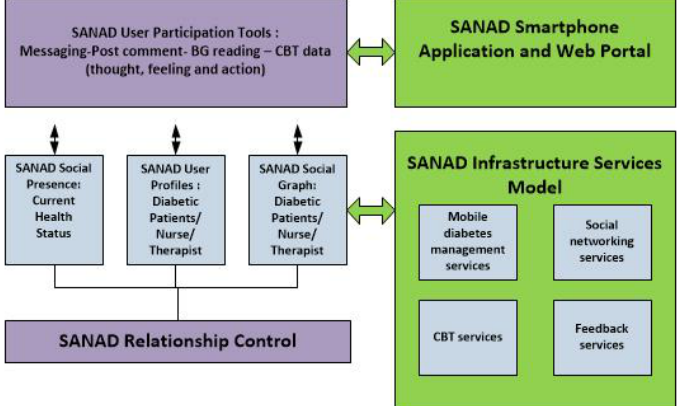
Figure 3. Building blocks of the Saudi Arabia Networking for Aiding Diabetes (SANAD) system. BG: blood glucose; CBT: cognitive behavioral